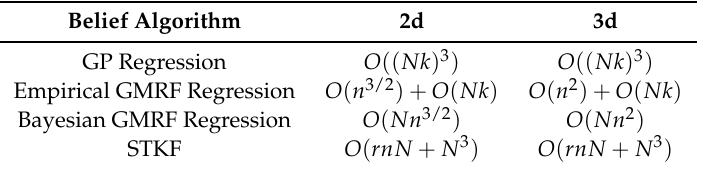
Table 1. Computational complexity of the developed belief algorithms for two and three dimensions of the field belief with number of agents N , number of discrete time steps k , number of field grid values n , and dimension of the state space model r